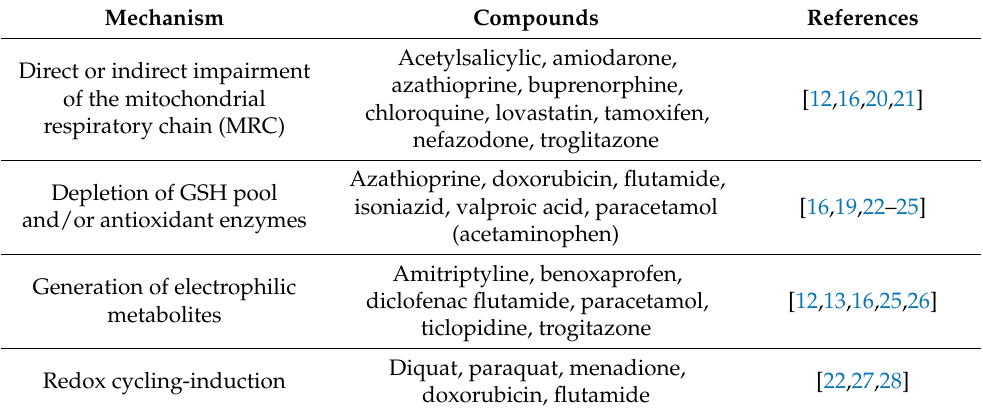
Table 1. Examples of toxic compounds able to induce oxidative stress and mechanisms